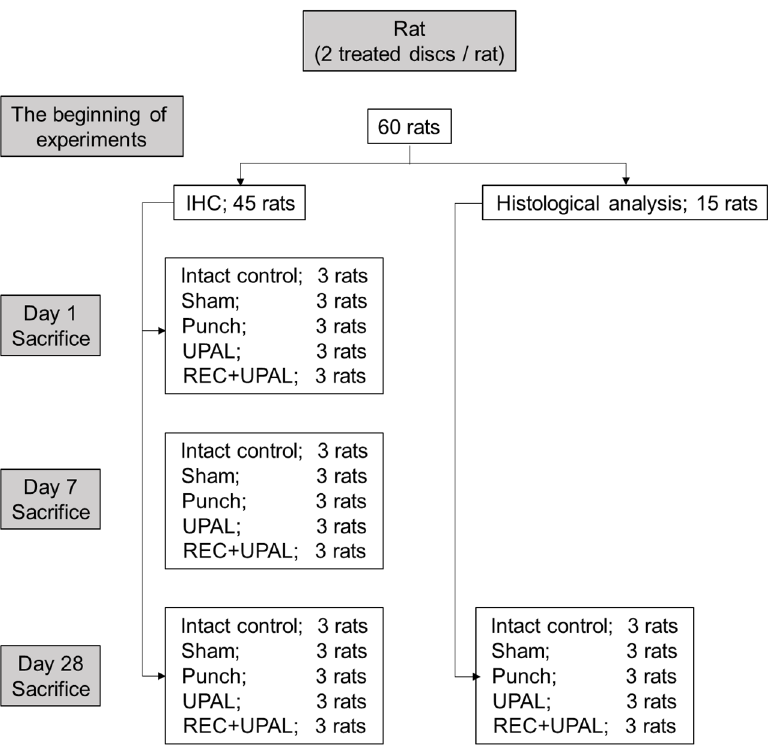
Figure 1. Schematic showing experimental setup, number of rats and treated discs, treatment groups, time points, and analysis.